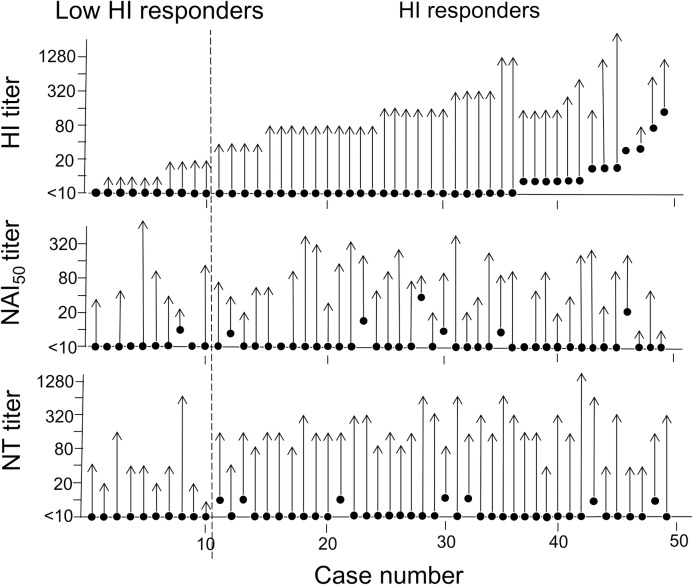
A shift of haemagglutinin inhibition, neuraminidase inhibition and neutralisation activities in individual paired sera of 49 naturally infected cases.Case number (abscissa) and the activities of the sera (ordinate). Solid circles, acute-phase titers; arrowheads, convalescent-phase titers. Only circles were cases without a shift between paired sera. The dotted line separates the haemagglutination-inhibition in low responders (HI-LR) and responders (HI-R) groups.